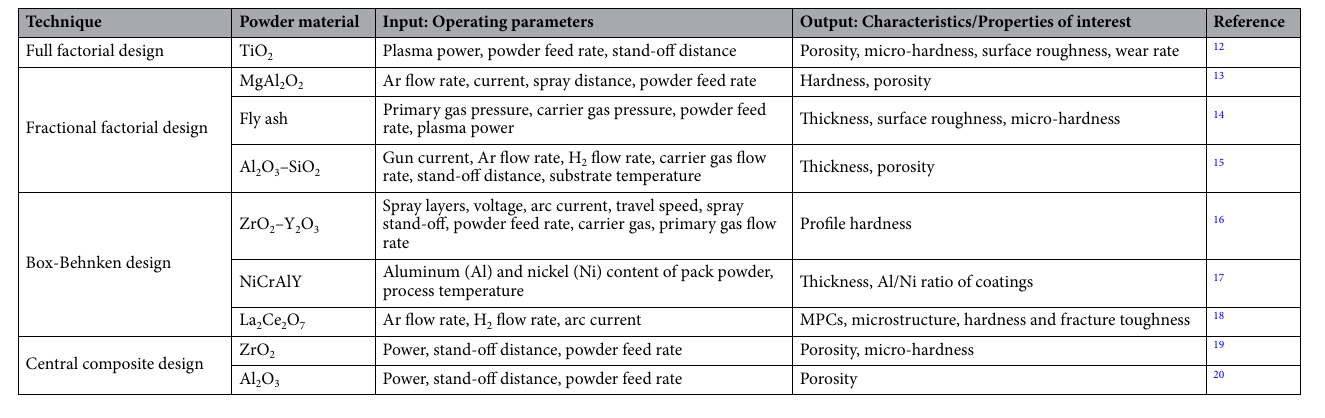
Table 1. Examples of the DoE applied to an